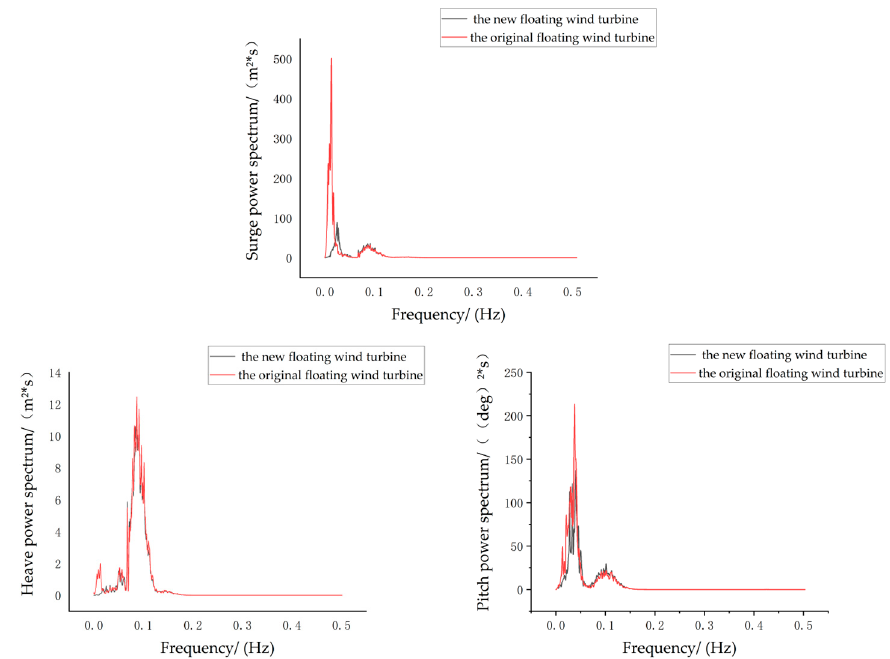
Figure 7. Comparison of platform movement in frequency domain under storm self-survival condition.